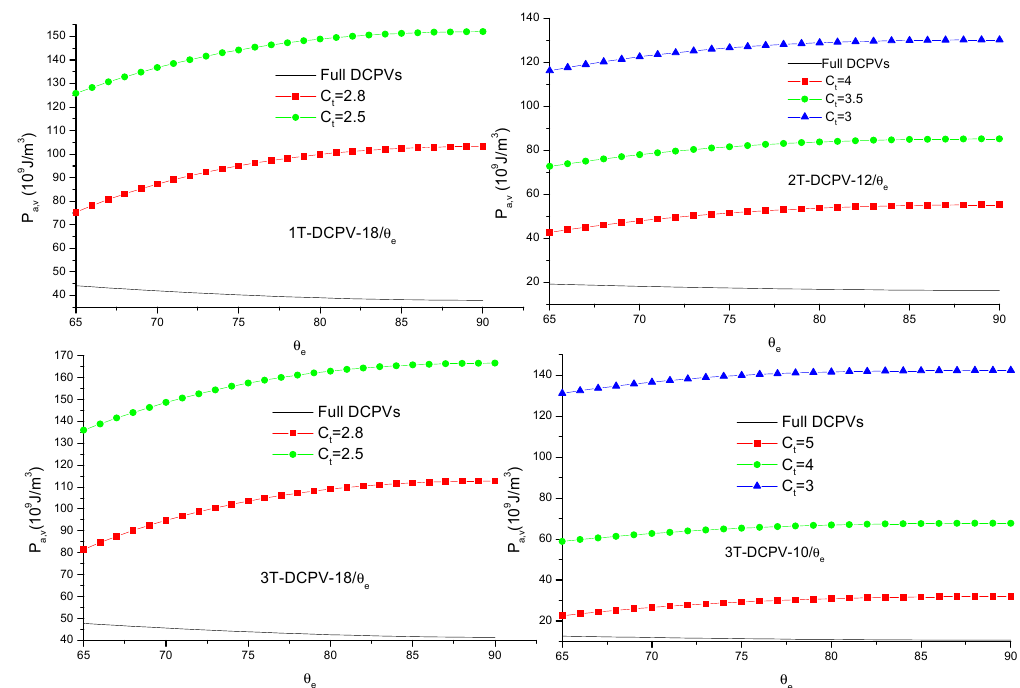
Figure 28. Effects of θ e on contribution per unit volume of dielectric to annual power output of θ on contribution per unit volume of dielectric to annual power output of Figure 28 . Effects of e DCPVs.